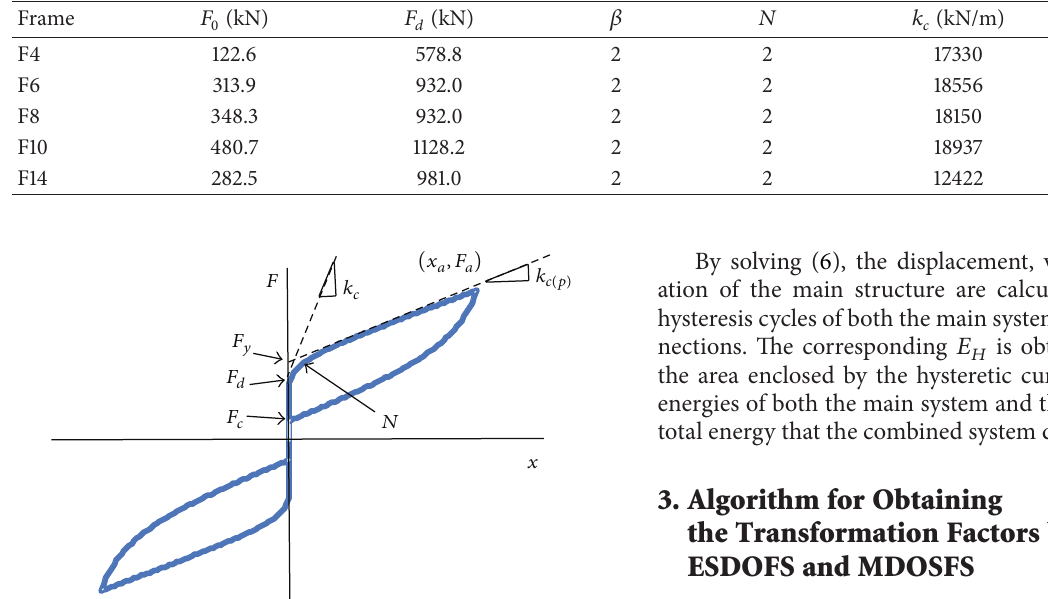
Table 1: Parameters used in (3) and (4).